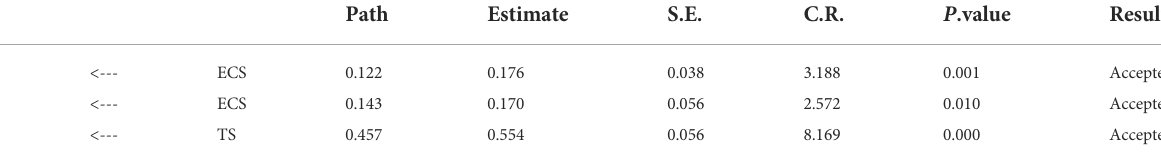
TABLE 4 Hypotheses